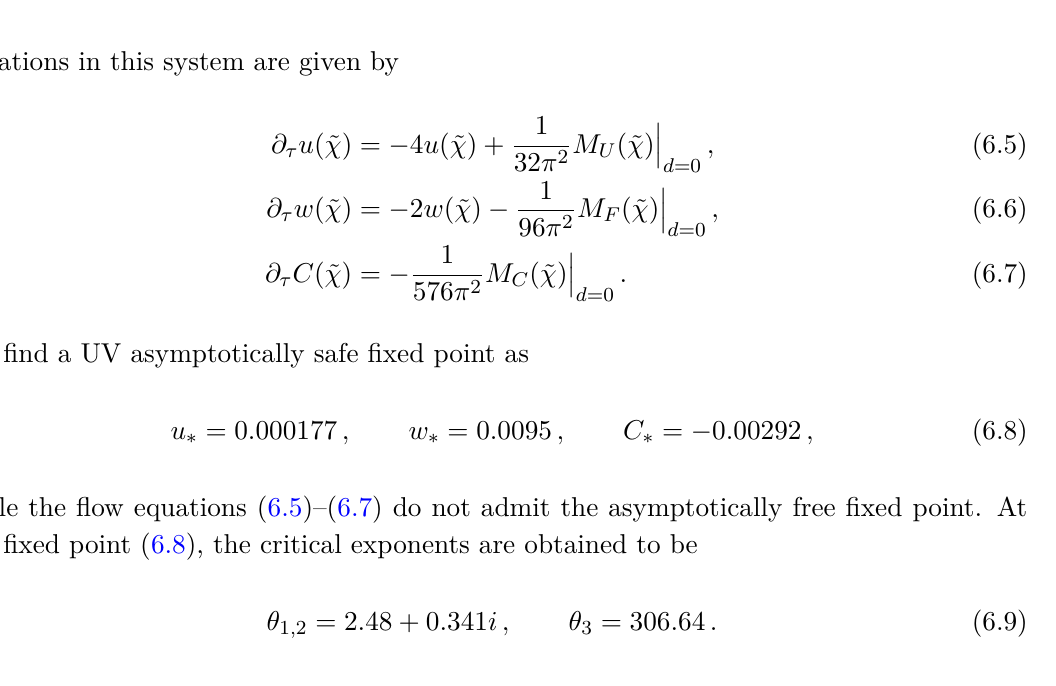
Figure 9 . Critical trajectory of u (˜ χ ) (top-left), w (˜ χ ) (top-right) and u (˜ χ ) /w (˜ χ ) 2 (bottom) as functions of ˜ χ in the Einstein-Hilbert truncation, for N S = N V = N F = 0